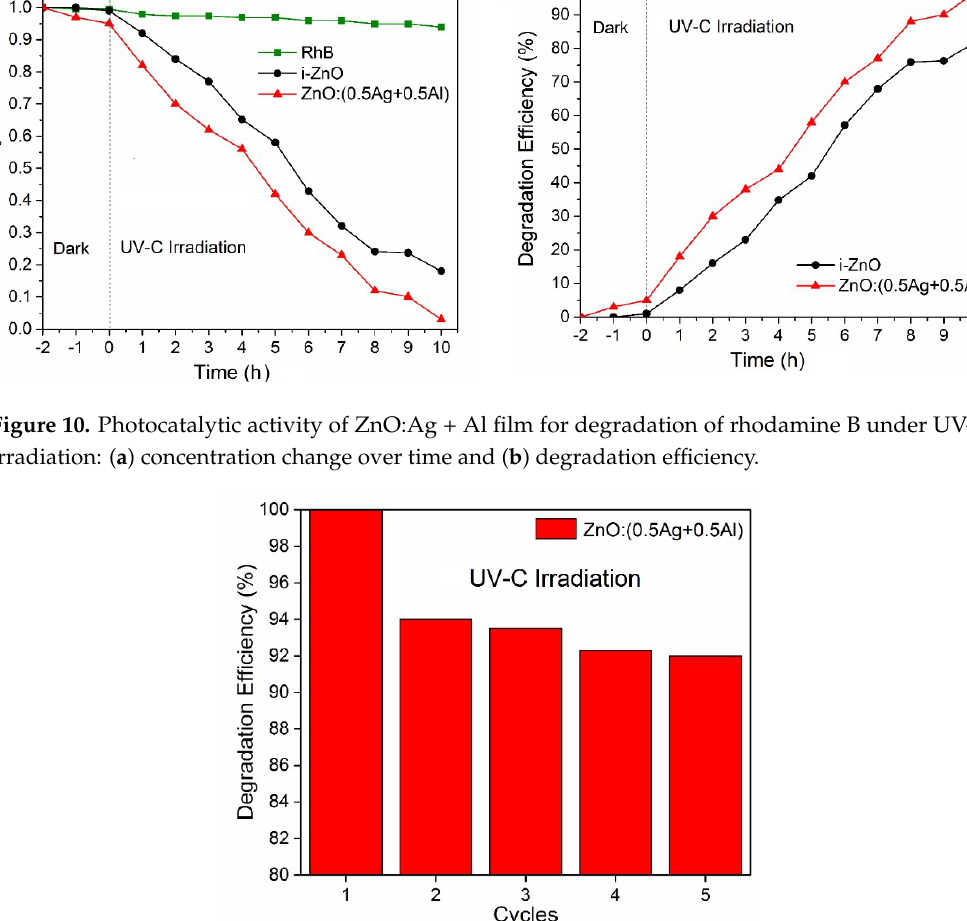
Figure 11. ZnO:Ag + Al film stability after several RhB degradation cycles under UV‐C irradiation.